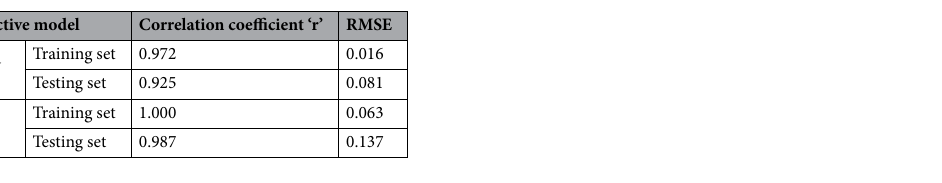
Table 11. Error comparison between BPNN and RF